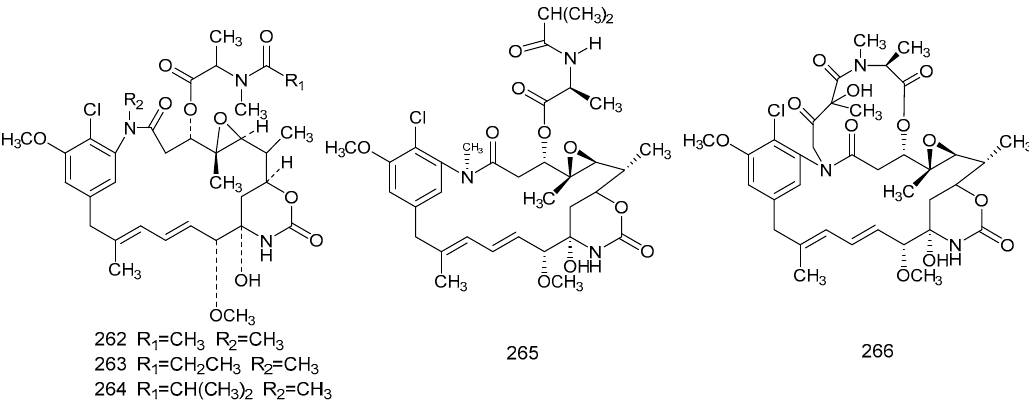
Figure 7. The chemical structures of maytansinoids , isolated from Maytenus.